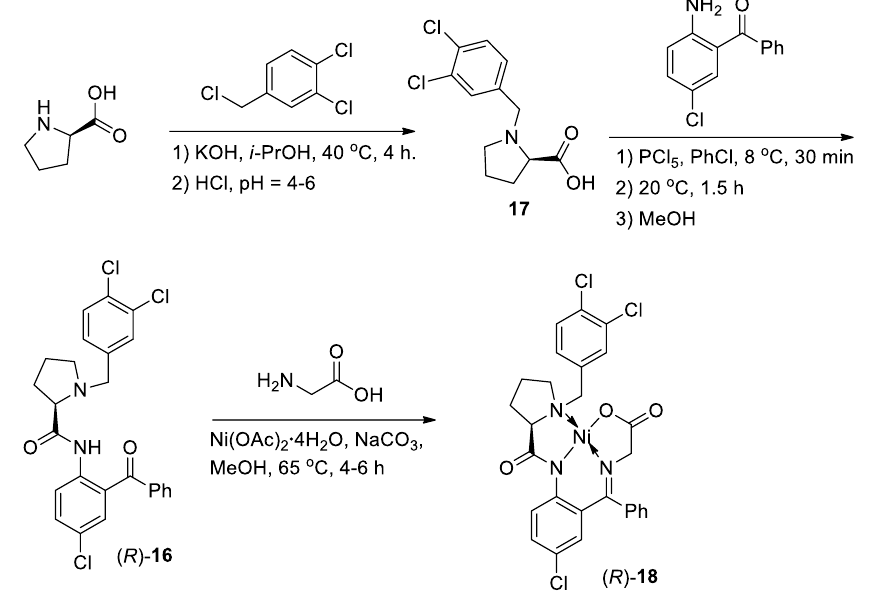
Scheme 2. Large-scale synthesis of ligand 16 and complex 18 .